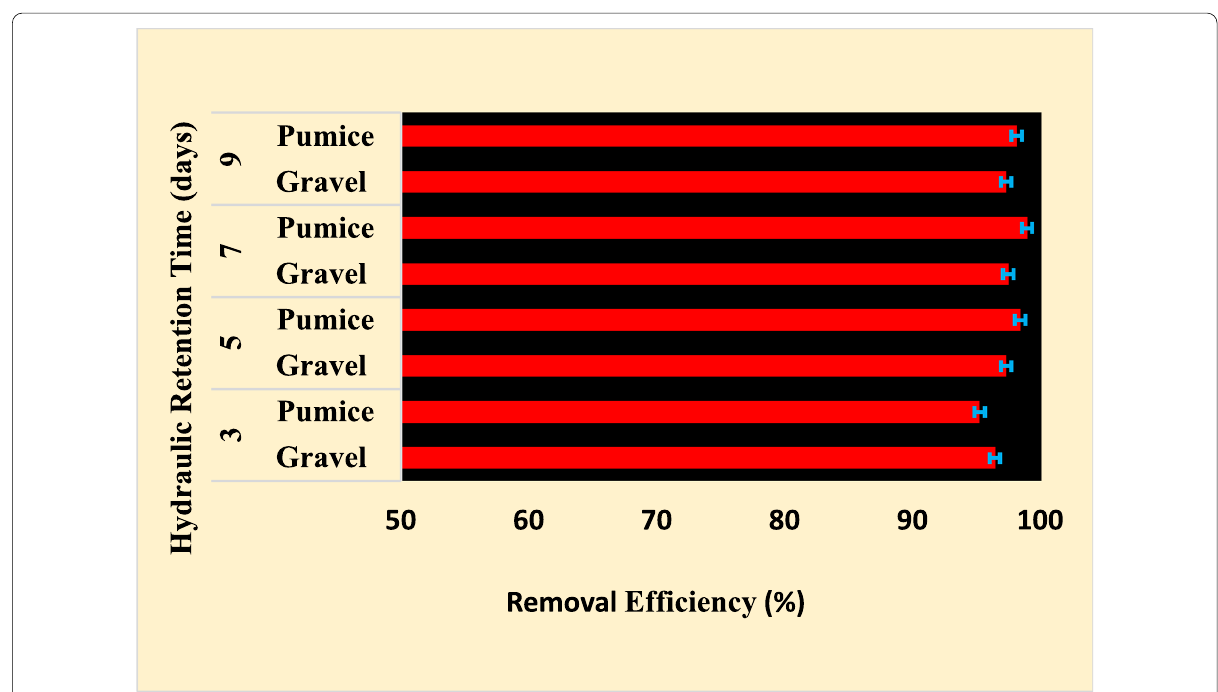
Fig. 8 Chromium removal efficiency of HSSFCW with gravel and pumice substrate